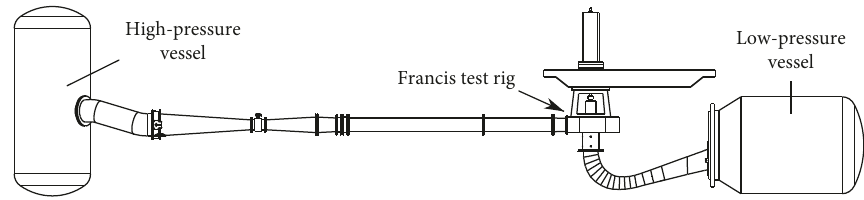
Figure 3: The Francis test rig, including the high- and low-pressure